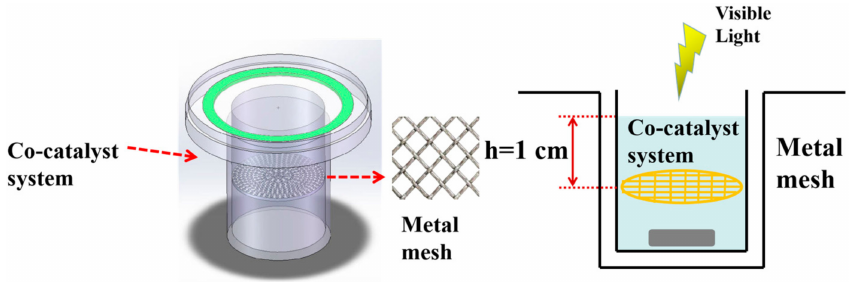
Figure 1. Schematic diagram of the reactor loaded with metal